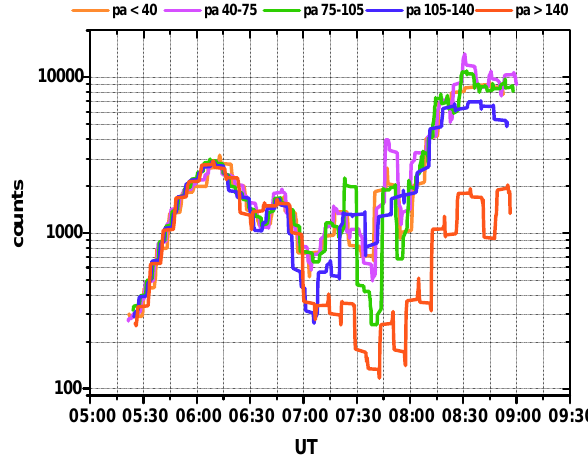
Fig. 3. Computed integral energy fluxes for different pitch angles (labeled at the top part of the figure) in the whole time interval. Data used are taken from the spectrograms in the middle panel of Fig. 2.